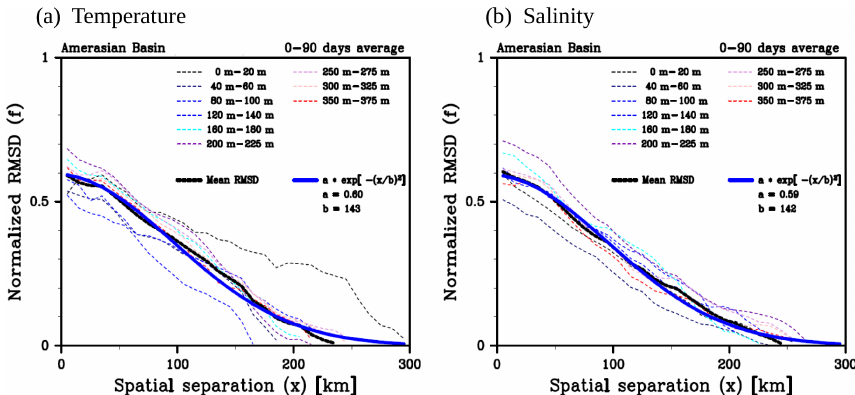
Figure 5. The 0- to 90-day temporal average of the function f (normalized RMSD) of (a) temperature and (b) salinity as a function of spatial separation. The thin-dashed lines denote functional form of RMSD in different depth levels, while the thick-solid black line in each panel denotes average of 0–400m depth range. The thick-solid blue line is the fitted Gaussian function, f (x) = a × exp [− (x/b) 2 ] , the fitting parameters of which are shown in each panel.